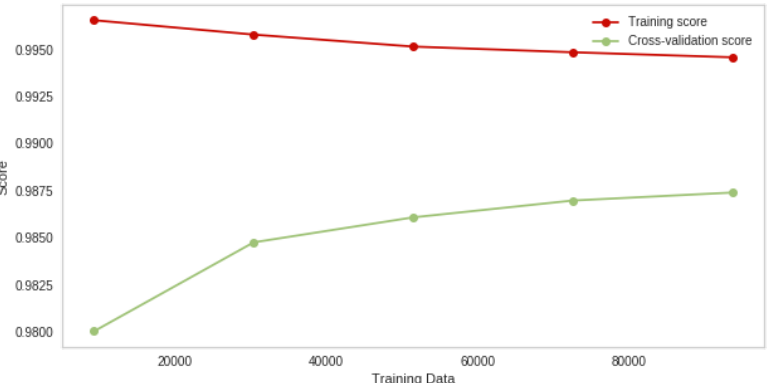
Figure 3. Random forest training learning